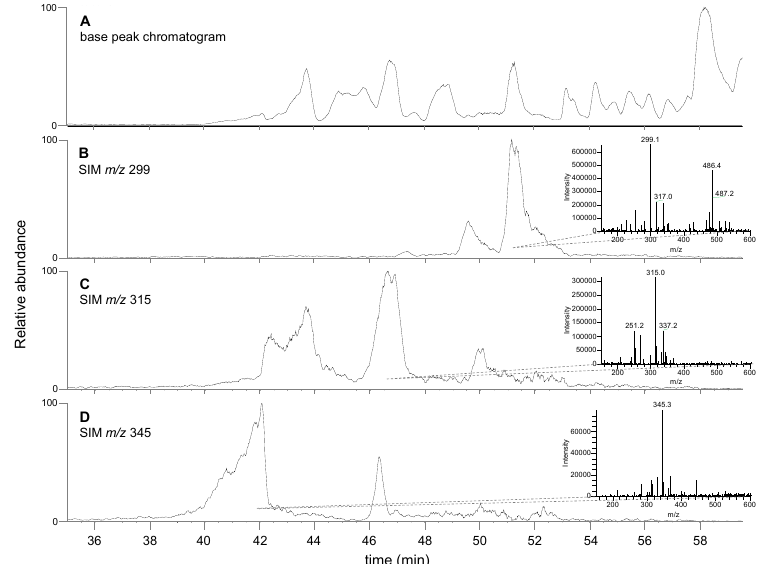
Figure 3. Analysis of chemical composition of T. lanatum extract using LC-MS. ( A ) Chromatogram generated by extracting the intensity of the base peak of the mass spectrum at each time point. Panels ( B – D ) represent the single ion chromatogram for the indicated m / z values which have been putatively matched the phenolic plant metabolites apigenin-7,4 (cid:48) -dimethyl ether (( A ), m / z 299), either scutellarein-6,7-dimethyl ether or 6-hydroxygalangin 5,6-dimethyl ether (( B ), m / z 315) and 6-hydroxy luteolin 6,7,4 (cid:48) -trimethyl ether (( C ), m / z 345). Insets in panels ( B – D ) show an averaged mass spectrum for each region corresponding to the largest peak in each SIM